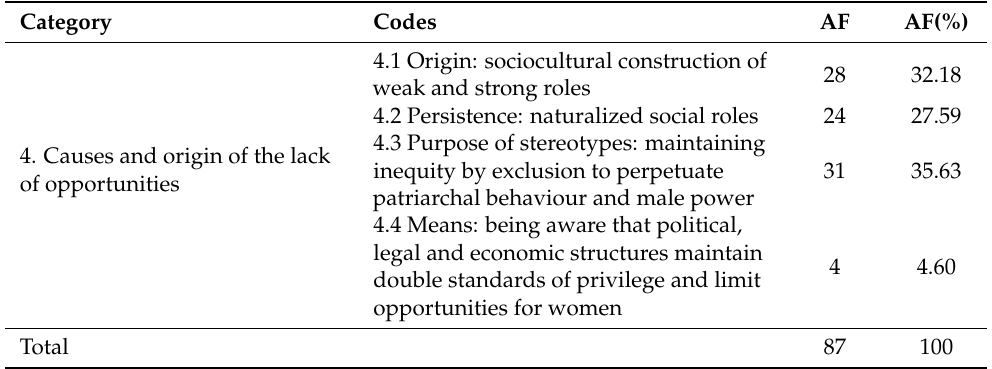
Table 4. Frequencies emerging from the narratives coded under Category